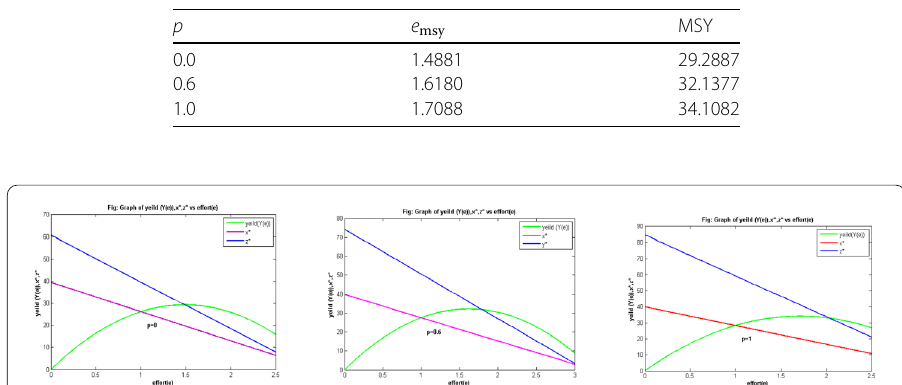
Figure 10 The changes in yield and population biomass with respect to the change in harvesting effort e . Here the value of parameter p has been varied in three different levels (the leftmost figure is for p = 0; the middle figure is for p = 0.6, and the rightmost figure is for p = 1)